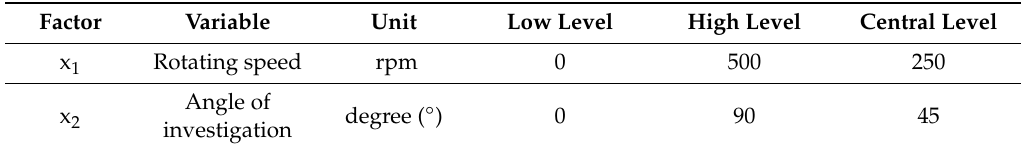
Table 1. Summary of the investigated variables and their experimental